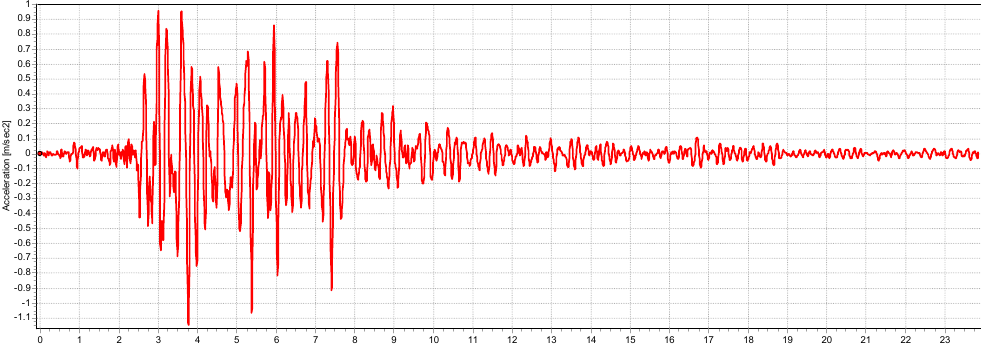
Figure 7. Petrovac earthquake acceleration scaled to 0.1 g [36].